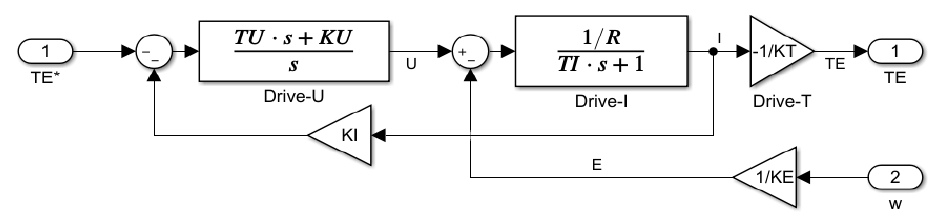
Figure 3. The replacement circuit of the electrical drive used for NN learning. Here, the Drive-U sub-block is responsible for direct torque control, electrical power supply, and energy recovery. Together with the Drive-I sub-block, it arranges a torque stabilization loop with a PI current regulator. The Drive-T sub-block and the Wheel block belong to the speed loop activated in gradual deceleration and shorted in emergency brak- ing. In the Wheel block (Figure 4), the static fraction of the application torque (Static T) is taken into account when the velocity drops to a low vehicle settling velocity level (vhome)